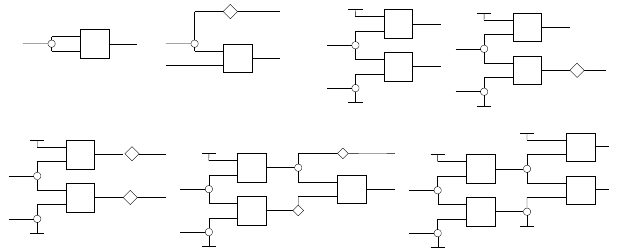
Figure 3. Diagrams for circuit instances of the CFD problem considered in Section 6, depending on the number of qubits, from these small, local, and dense circuits. Every box is a two intput/one output gate, every dot is a one input/two output gate, and every diamond is a one intput/one output gate. If a top wire has a (cid:62) and a bottom wire has a ⊥ at the same depth, they refer to the same wire (which has been wrapped